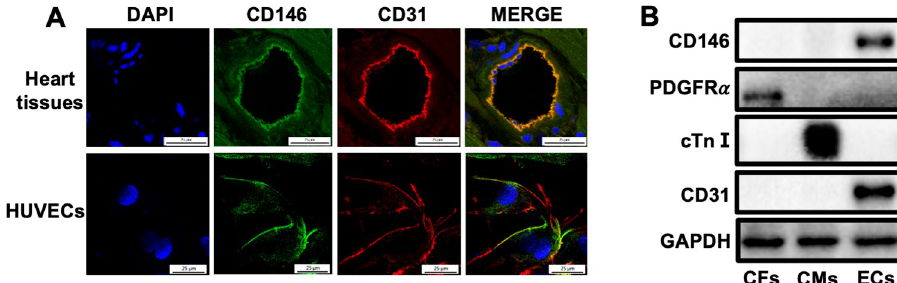
Fig 1. CD146 is predominantly expressed in ECs of adult mouse hearts. A CD146 expression in adult mouse hearts and HUVECs was determined by immunofluorescence staining (scale bars indicate 25 μ m). Green represents CD146; red represents CD31; blue represents nuclei. B CD146 protein expression in CFs, CMs and ECs isolated from adult mouse hearts was detected by Western blot analysis. GAPDH served as an internal control. CFs: cardiac fibroblasts, CMs: cardiac myocytes, ECs: endothelial cells, cTnI: cardiac troponin I.